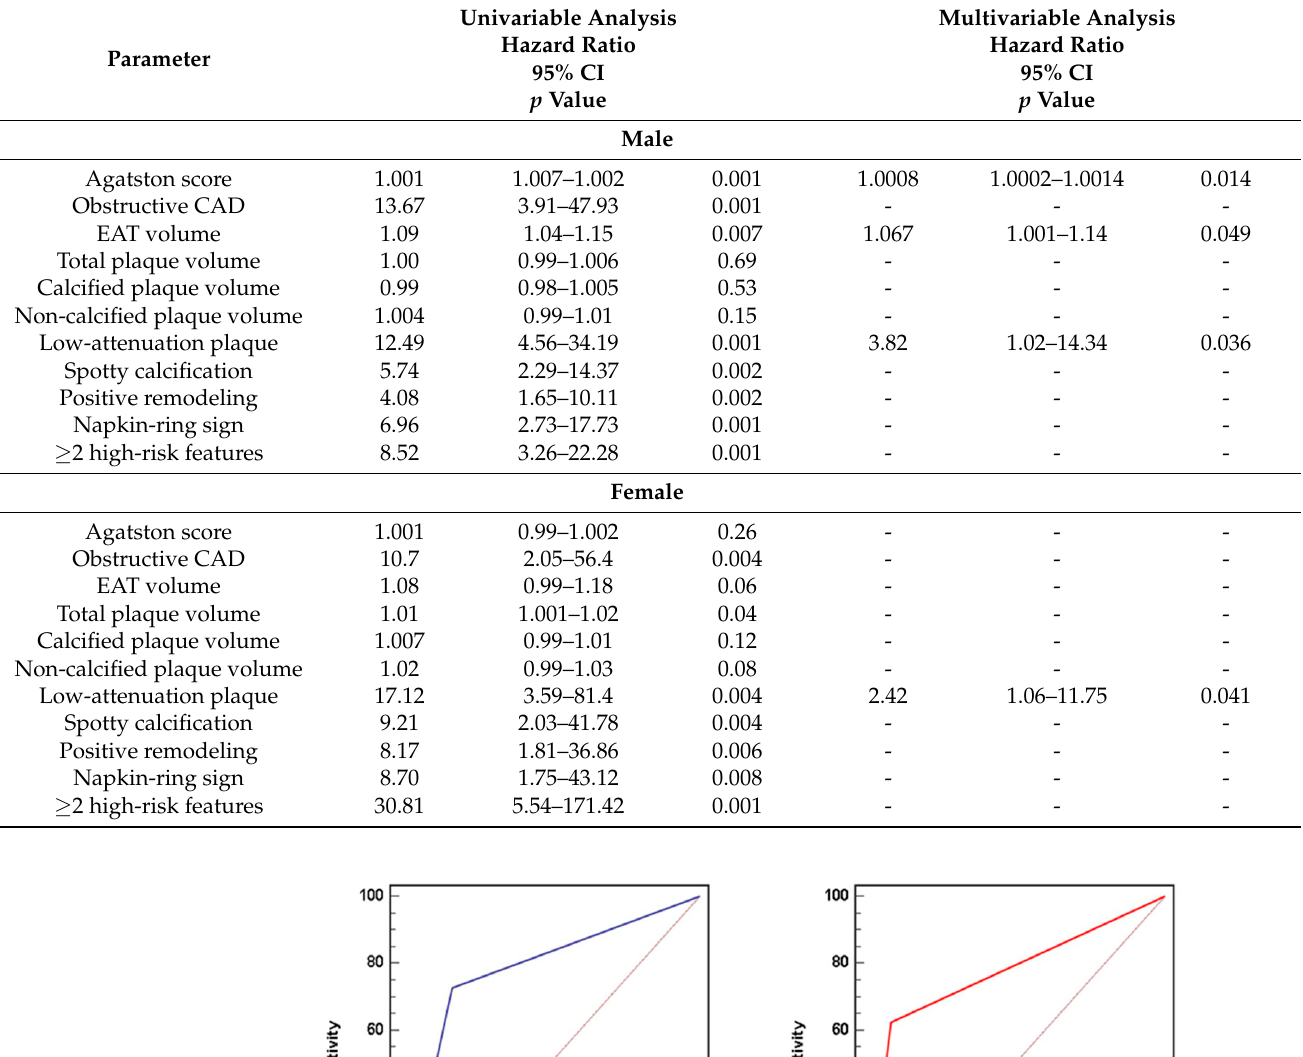
Table 4. Univariable and multivariable Cox proportional hazards regression analysis of coronary CT-derived parameters in men and women for the prediction of MACE.